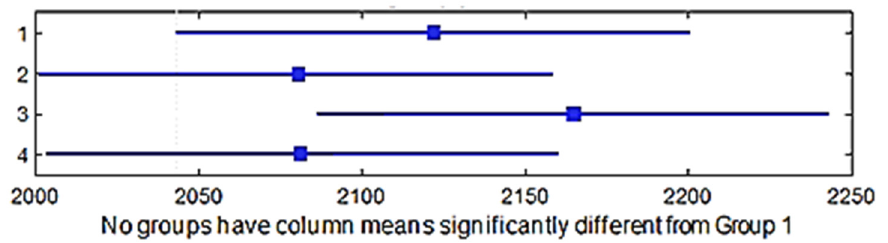
Figure 13. Confidence intervals of the air permeability of different weave groups.